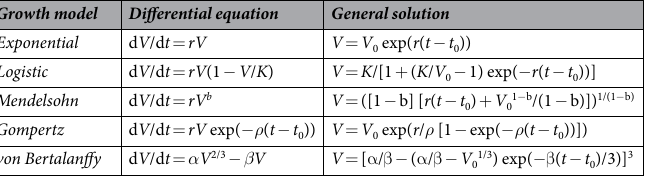
Table 3. Description of each of the growth models tested. Parameters r and α represent the tumour growth rate (per day), K the carrying capacity of the tumour, b an exponent determining the shape of the growth curve, ρ the proportional rate of decrease in growth rate, and β the rate of loss due to cell death (see Gerlee 2013 for